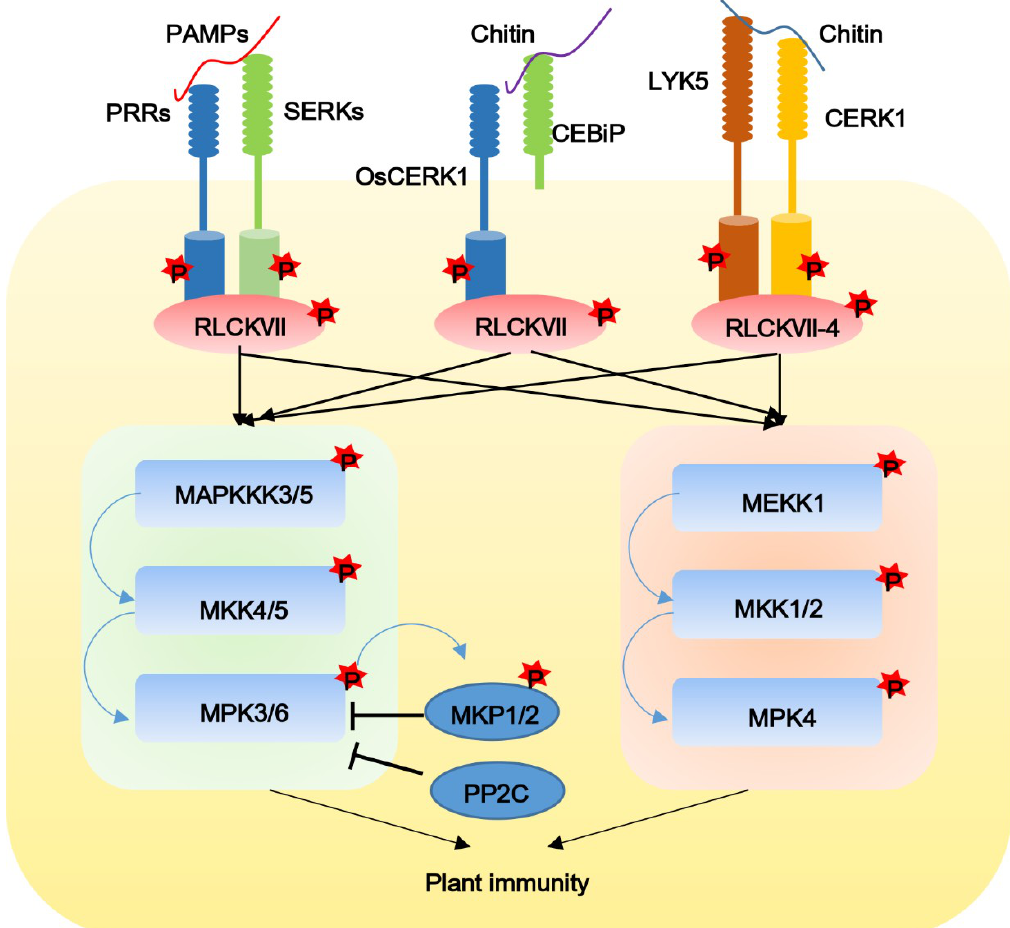
Figure 2. RLCKs and MAPK cascades function downstream of diverse PRRs to activate plant immune signals. Ligand perception induces rapid immune receptor complex formation and transphosphorylation. Several RLCK VII members rapidly become phosphorylated, which further activates evolutionarily conserved mitogen-activated protein kinase (MAPK) signaling modules, thereby activating pathway-specific transcription factors to activate plant immunity.